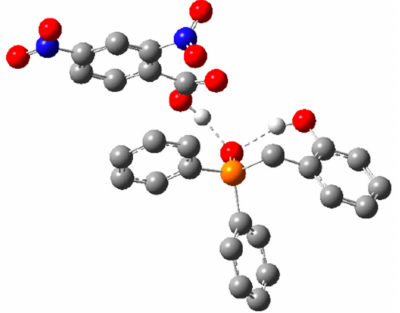
Figure 6. Optimized ground state structure GS B for 1a and DNBA. Hydrogen atoms not involved in hydrogen bonding have been omitted for clarity. Hydrogen atoms shown in white, carbon atoms shown in gray, nitrogen atoms shown in blue, oxygen atoms shown in red, and phosphorus atoms shown in